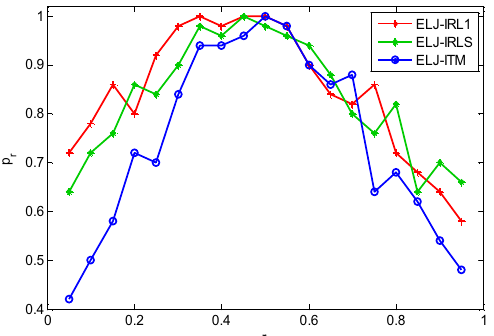
Figure 5. Probability of finding the globally optimal sparse solution for different rate r